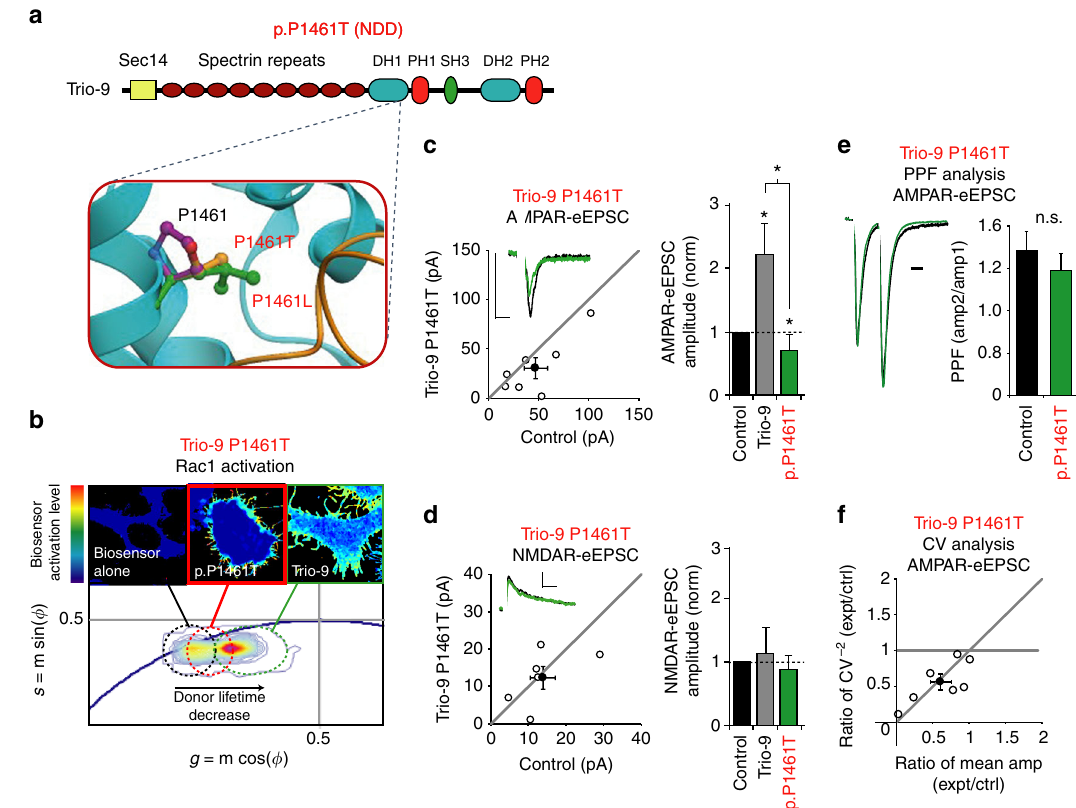
Fig. 6 Trio-9 p.P1461T expression reduces the strength of glutamatergic synapses. a Predicted alteration to Trio ’ s GEF1 domain resulting from Trio-9 P1461T. NDD, neurodevelopmental disorder. b Trio-9 P1461T inhibits Trio-9 ’ s ability to activate Rac1. Representative FLIM color maps of HEK293 cells expressing the Rac1 biosensor alone, the biosensor and Trio-9 P1461T or the biosensor and Trio-9 are shown above. A cropped phasor plot for each condition is shown below. Dashed ovals identify the lifetime distribution for each condition. Complete phasor plots are shown in Supplementary Fig. 2. c , d Scatterplots show eEPSC amplitudes for single pairs of control and transfected neurons ( open circles ). Filled circles show mean ± SEM. ( Insets ) Current traces from control ( black ) and transfected ( green ) neurons ( Scale bars : 20 ms for AMPA, 50 ms for NMDA, 20 pA). Bar graphs show the average eEPSC amplitudes ( ± SEM) of neurons expressing Trio-9 (in gray , from Fig. 4j, k) and Trio-9 P1461T normalized to their respective average control eEPSC amplitudes. In the bar graphs a Wilcoxon Rank Sum Test was used to compare across independent conditions (i.e., Trio-9 and Trio-9 P1461T in c , *P < 0.05). c Trio-9 P1461T expression reduced AMPAR-eEPSC amplitude ( n = 7 pairs, * P < 0.05, Wilcoxon Signed Rank Test). d Trio-9 P1461T expression did not affect NMDAR-eEPSC amplitude ( n = 6 pairs, P > 0.05, Wilcoxon Signed Rank Test). e Mean ± SEM paired-pulse facilitation (PPF) ratios for Trio-9 P1461T expressing and paired control neurons ( n = 5 pairs, P > 0.05, Student ’ s t- test). Peak 1-scaled current traces from control ( black ) and transfected ( green ) neurons ( Scale bar : 20 ms). n.s., not signi fi cant. f CV analysis of AMPAR-eEPSCs from pairs of control/Trio-9 P1461T neurons. CV − 2 graphed against ratio of mean amplitude within each pair ( open circles ). Filled circle shows mean ± SEM. ( n = 7